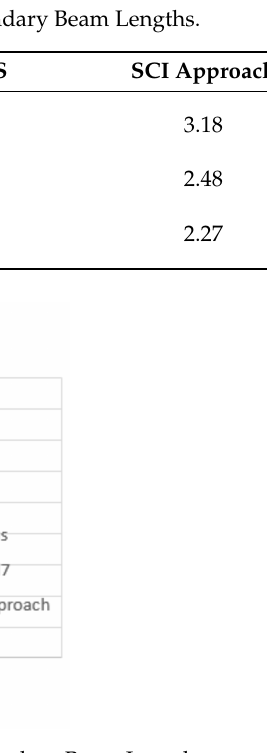
Figure 16. Comparison of Response Factor between Different Secondary Beam Lengths.